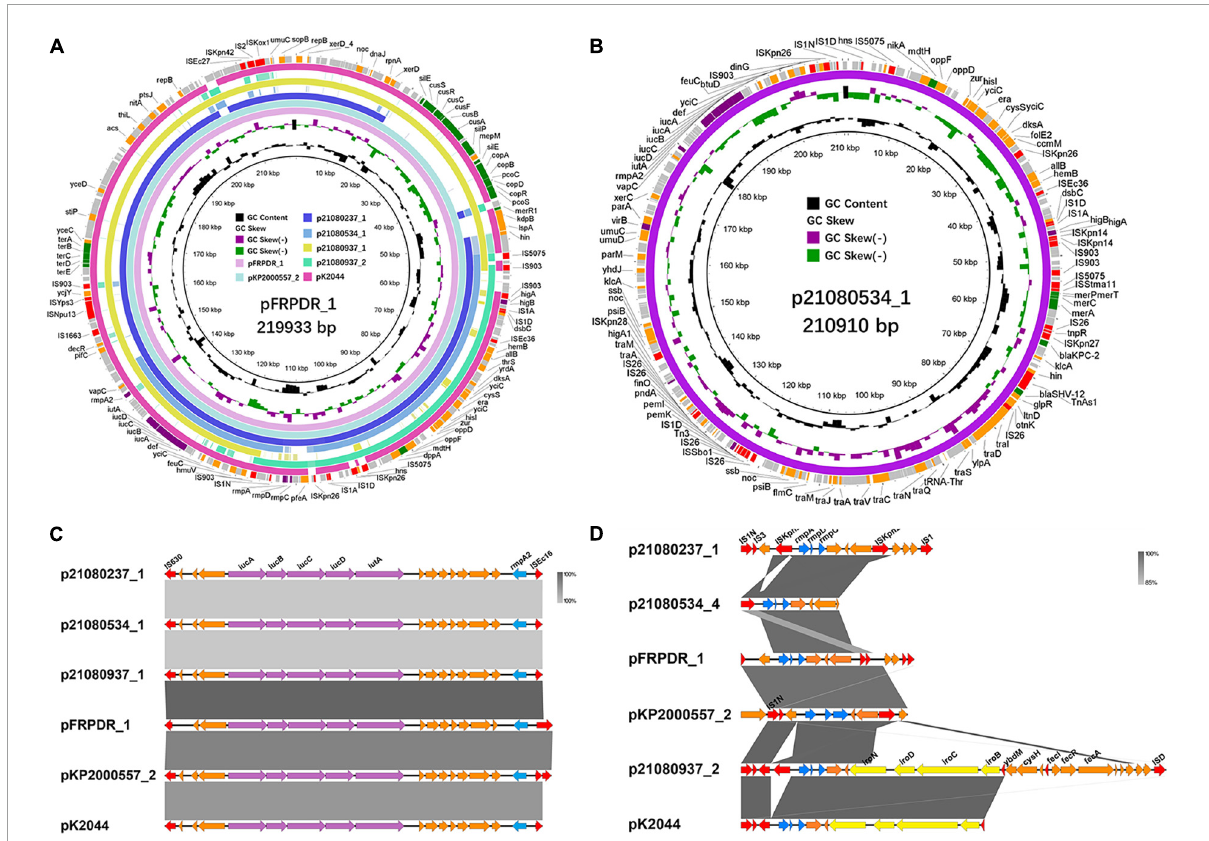
FIGURE5 Alignment of hypervirulence plasmids in ST11 MDR-hvKps and comparison of rmpA , rmpA2 gene clusters in different MDR-hvKps. (A) Alignment of plasmid p21080237_1, plasmid p21080534_1, plasmid p21080937_1, plasmid p21080937_2, plasmid pFRPDR_1, plasmid pKP2000557_2, and plasmid pK2044 (GenBank Accession No. AP006726) using the BLAST Ring Image Generator (BRIG 0.95) (Alikhan et al., 2011). (B) Plasmid map of MDR and hypervirulence plasmid p21080534_1. (C) Comparative analysis of rmpA2 surrounding genes of MDR-hvKps, plotted using